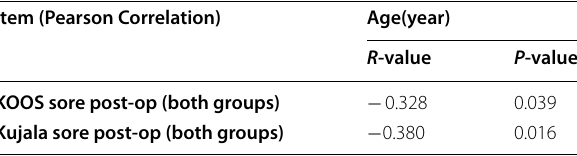
The correlation between age and outcome (post-op scores for Kujala and KOOS) was fair negative statistically significant Correlation is significant at the 0.05 level (2-tailed)